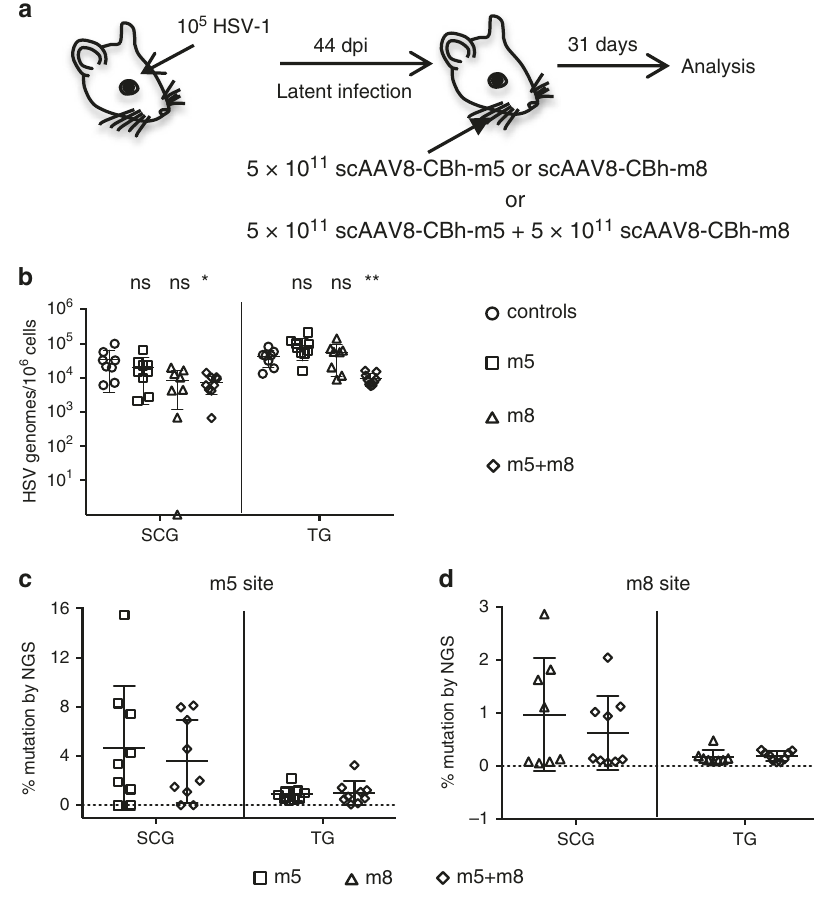
Fig. 1 HSV load reduction in dual-meganuclease-treated mice. a Mice latently infected for 44 days with 10 5 PFU HSV-1 17 + were left untreated (Controls, circles n = 8) or administered by whisker pad injection either 5 × 10 11 vgs scAAV8-CBh-m5 (squares, n = 9), 5 × 10 11 vgs scAAV8-CBh-m8 (triangles, n = 8) or 5 × 10 11 vgs of each scAAV8-CBh-m5 and scAAV8-CBh-m8 (diamonds, n = 9). Analysis was performed 31 days later. b ddPCR quanti fi cation of HSV genomes in SCG and right (ipsilateral) TGs from infected mice ( p = 0.018 in SCG of controls vs m5 + m8; p = 0.001 in TG of controls vs m5 + m8). c , d NGS analysis of m5 and m8 sites in HSV genomes from SCGs and right (ipsilateral) TGs from infected mice treated with either m5 (squares, n = 9), m8 (triangles, n = 8) or m5 + m8 (diamonds, n = 9). ns: not signi fi cantly different from controls, * p < 0.05, ** p < 0.01, *** p < 0.001, signi fi cantly different from controls. All data are presented as mean values ± SD. Statistical analysis was conducted using unpaired multiple t -test without correction for multiple